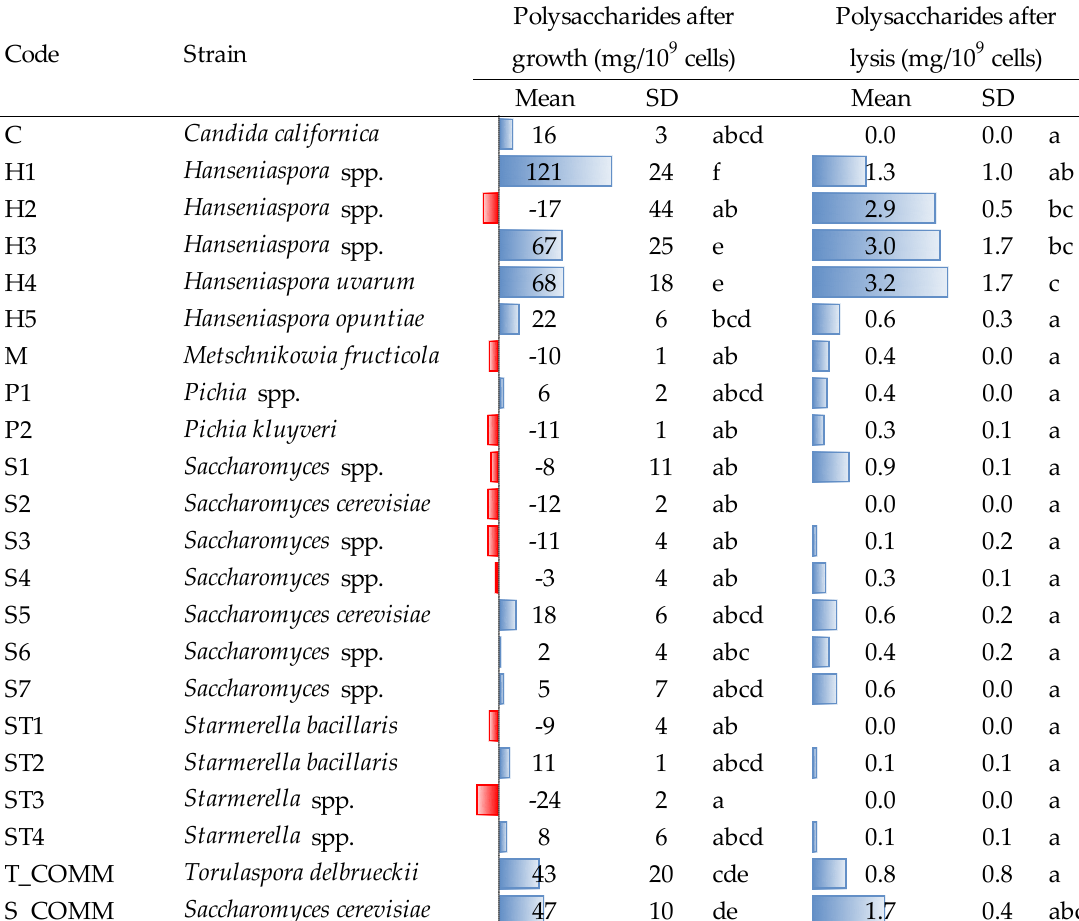
Figure 2. Polysaccharides released by the different strains after growth (48 h, YPD medium, 30 °C) and after lysis induced by β -glucanase enzymes. Data are means and standard deviations (SD) of three repetitions. Different letters mark significant differences according to ANOVA and Tukey HSD test at p < 0.05. T_COMM, S_COMM: commercial active dry yeast preparations. Concerning the values detected after growth, positive and negative values (blue and red bars) indicate, respectively, an increase/production or a decrease/consumption, with respect to the initial composition of the YPD medium.